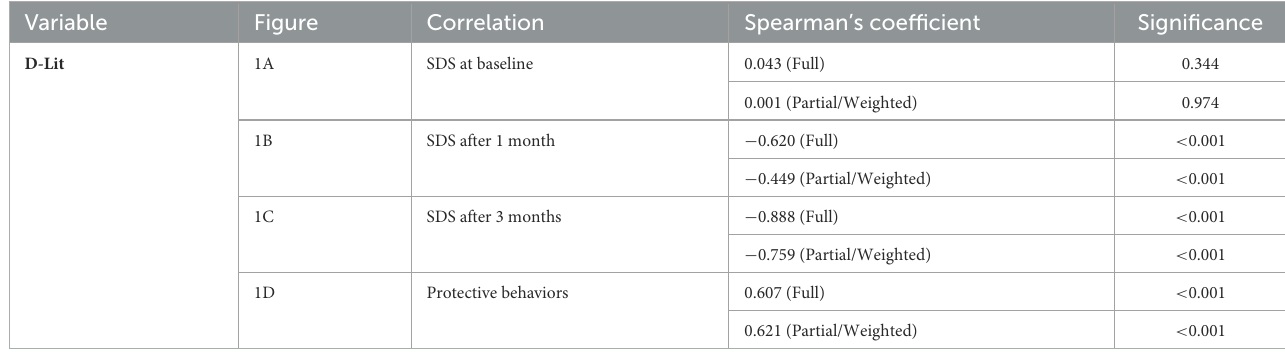
TABLE 3 Statistical correlation between D-Lit of participants and Zung SDS at baseline, after 1 month, after 3 months; and proactive attitudes of participants in performing protective behaviors against depressive mood. Variable Figure Correlation Spearman’s